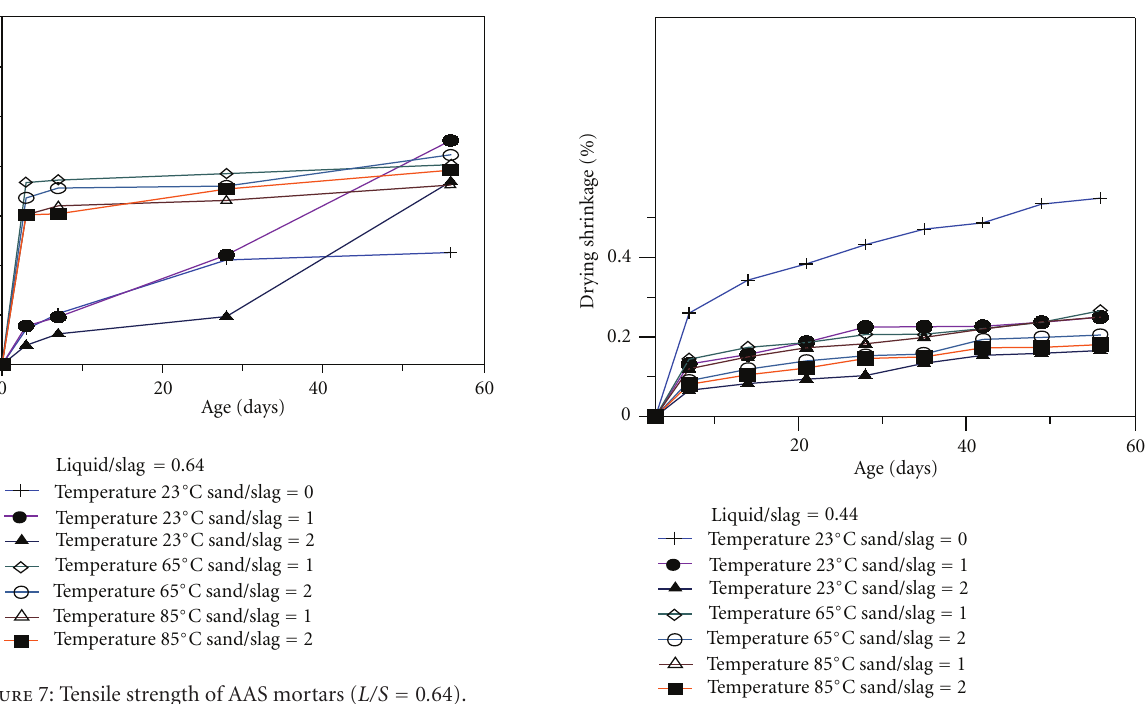
Figure 9: Drying shrinkage of AAS mortars ( L/S = 0 .